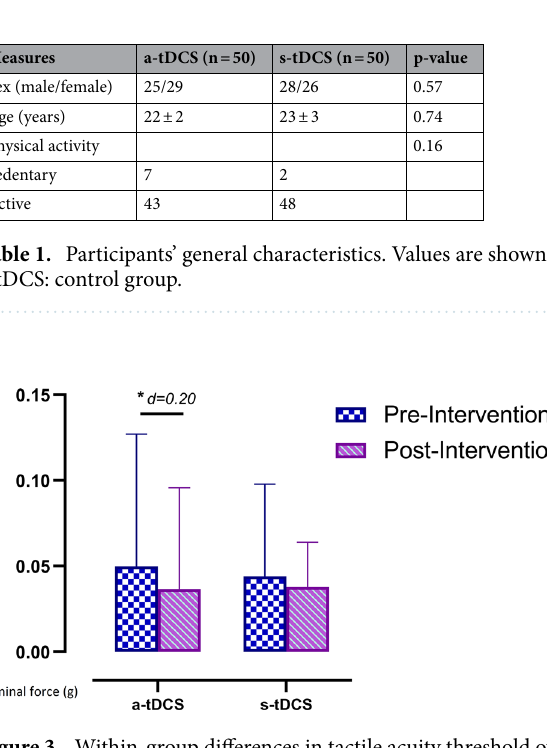
Figure 3. Within-group differences in tactile acuity threshold over thenar eminence of the hand. a‑tDCS active transcranial direct current stimulation, s‑tDCS sham transcranial direct current